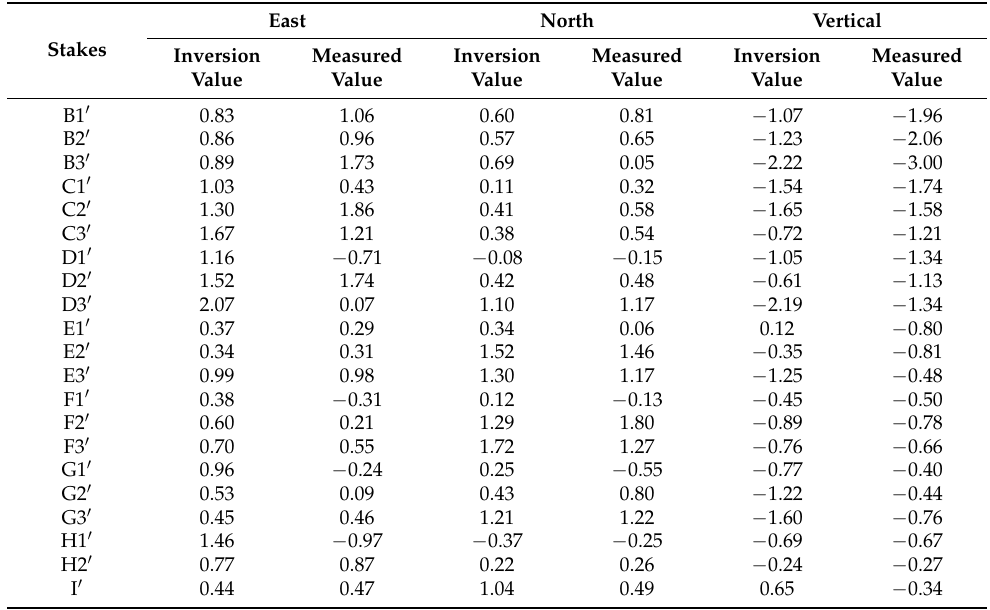
Figure 5. Displacement distribution of the west branch of No.1 Glacier in three directions (unit: m). Table 1. The inversion value and the measured value of UG1E in three directions (unit: